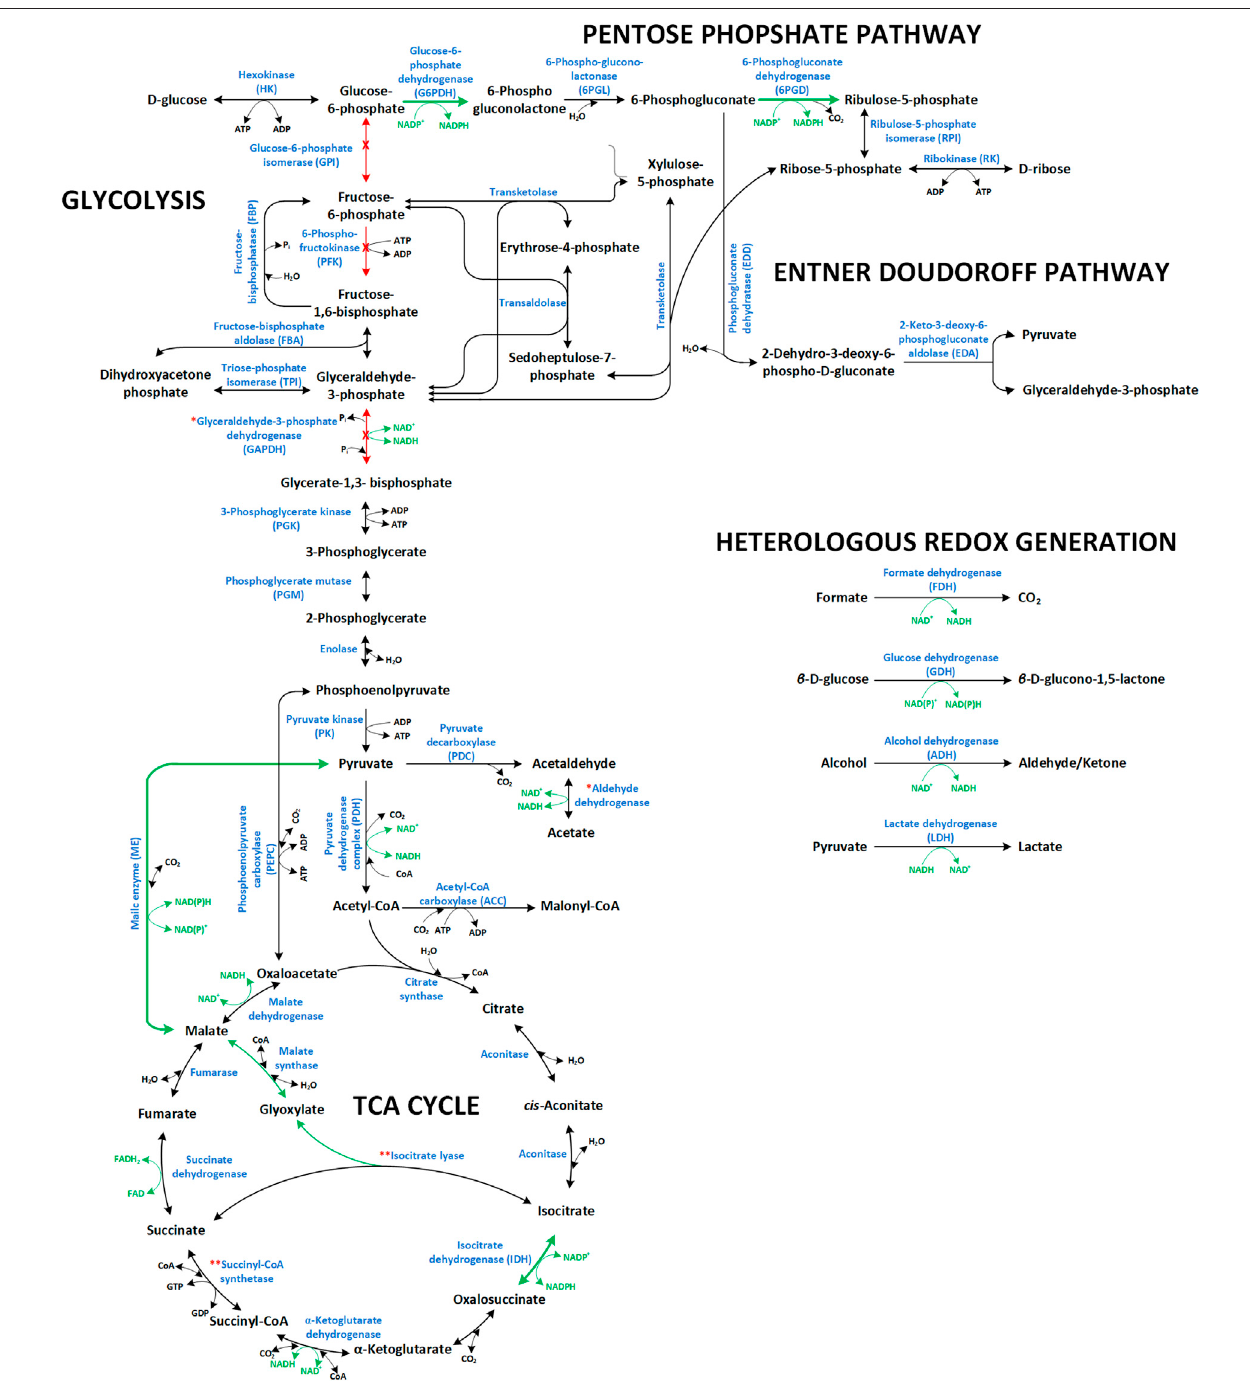
FIGURE2| OverviewoftheNAD(P) + /NAD(P)Hdependentreactionsincentralcarbonmetabolicmodules(glycolysis,pentosephosphatepathway,TCAcycle,and Entner-Doudoroffpathway)andheterologousredoxcofactorregenerationsystemscommonlyusedtofuelredox-intensiveproductionprocesses.Greenarrowsandred arrows indicate reactions, which have been upregulated and downregulated/deleted, respectively, to promote/improve redox intensive production schemes. Enzyme names are accompanied bytheir abbreviationsascited inthe text. Respective genesare: the PPPgenes zwf (glucose 6-phosphatedehydrogenase, G6PDH ) and gnd (6-phosphogluconate dehydrogenase, 6PGD ) both encoding NADPH forming enzymes (Lim et al., 2002; Poulsen et al., 2005; Zhang et al., 2016a); the glycolytic genes pgi (glucose-6-phosphate isomerase, GPI ), pfkA /B (phosphofructokinase I/II, PFK ), and gap A (G3P dehydrogenase, GAPDH ); the TCA cycle genes maeA/B (malic enzyme , ME ) and icd (Isocitrate dehydrogenase, IDH ). The symbol ( * ) denotes enzymes that can be exchanged with functionally equivalent isozymes but with different cofactor preference (i.e., NADP + -dependent variants of aldehyde dehydrogenase and GAPDH). The symbol ( ** ) denotes reactions that have been either